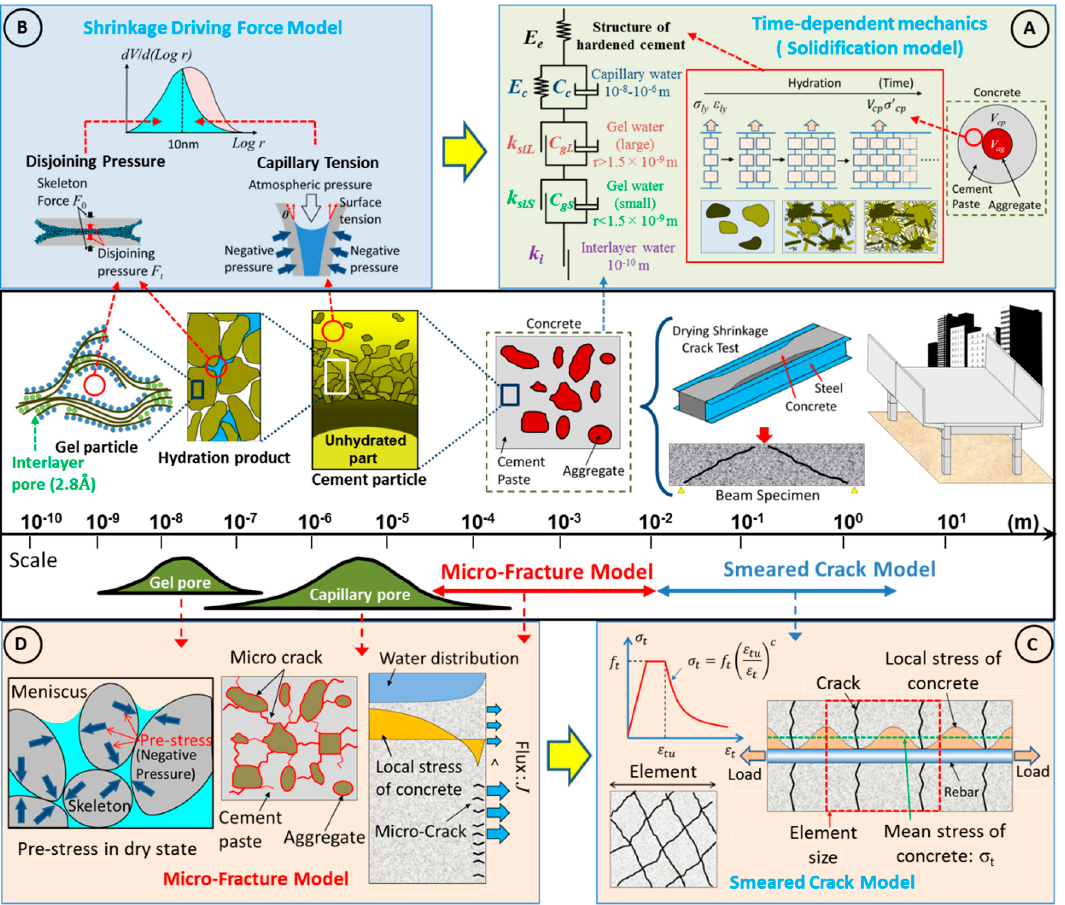
Figure 2. Multiscale and multi-physical modelling to simulate time-dependent deformation and cracking.